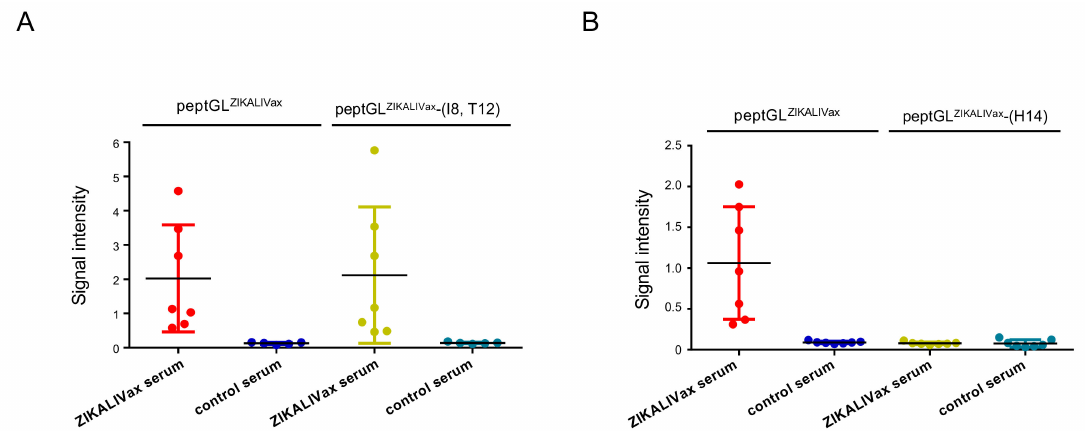
Figure 3. Immunoreactivity of peptGL ZIKALIVax mutants with anti-ZIKALIVax immune serum. The O.D 450 or signal intensity of individual anti-ZIKALIVax immune sera in relation to peptGL ZIKALIVax and its mutants at positions 8 and 12 ( A ) or 14 ( B ) measured through peptide-based ELISA. Peptides at concentration of 3 µ g mL − 1 were incubated with individual anti-ZIKALIVax immune sera ( n = 7) (ZIKALIVax serum) showing the higher reactivity with peptGL ZIKALIVax at dilution 1:200 (Figure 2B). Serum of mice ( n = 7) that received heat-inactivated ZIKALIVax at dilution 1:200 served as a control serum. Each closed circle represents an individual mouse.